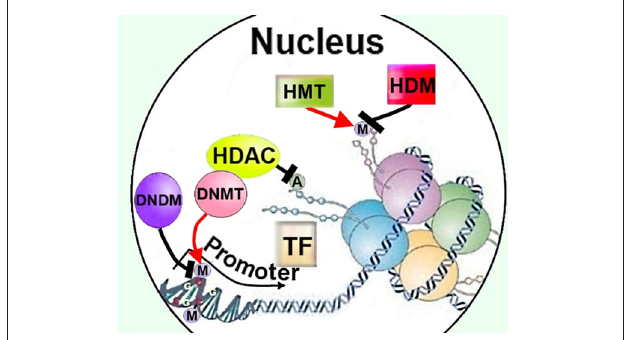
FIGURE 3 | Regulation of cellular methylation could affect neurite growth though modifying DNA or histones, as well as by recruiting HDACs to promoters. HDAC, histone deacetylase; M, methylation; A, acetylation; TF, transcription factor; HMT, histone methyltransferase;